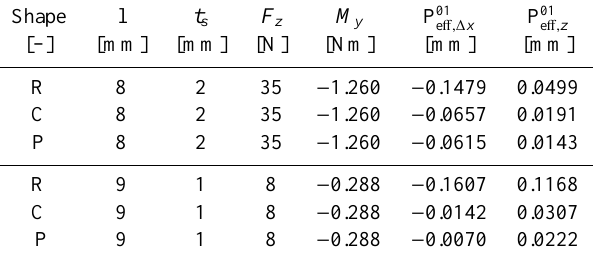
Table 5. Natural frequencies for rectangular (R), circular (C) and parabolic (P) flexure hinges connected to a rigid body ( H = 10mm, L = 50mm, b = 10mm).